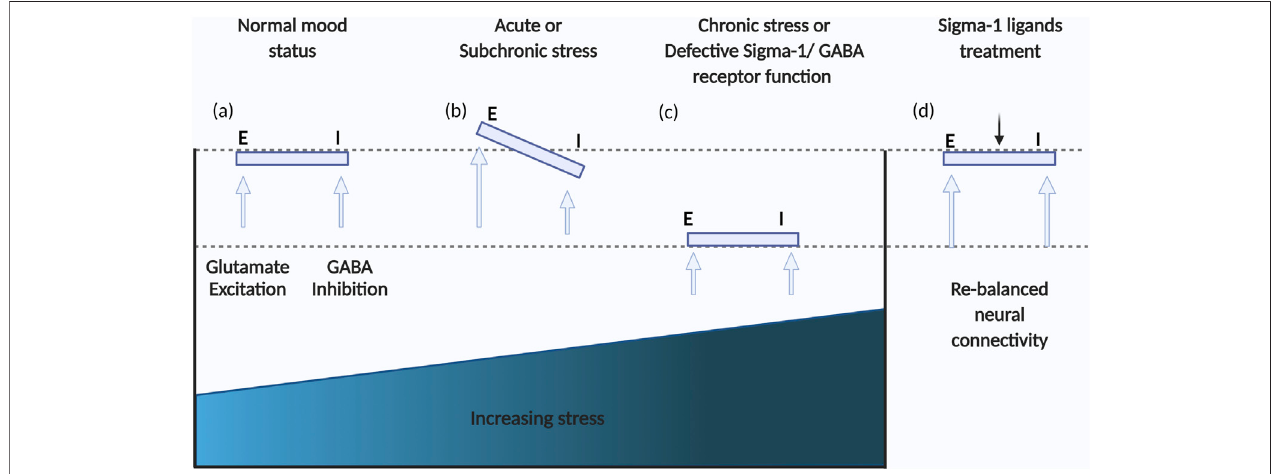
FIGURE 2 | Schema of the dynamic balance of GABAergic and glutamatergic neurotransmission. (A) In a normal mood status, GABAergic and glutamatergic neurotransmission arebalanced; (B) Acute stresscan result in imbalancesbetween GABAergic and glutamatergic neurotransmission; (C) Further adaptation tochronic stress may result in a new balance of GABAergic and glutamatergic neurotransmission but at lower levels, contributing to depression; (D) Regulating 5-HT-Glu/GABA long neural circuit through treatment with sigma-1 receptor ligands has the potential to rapidly restore the primary balance and